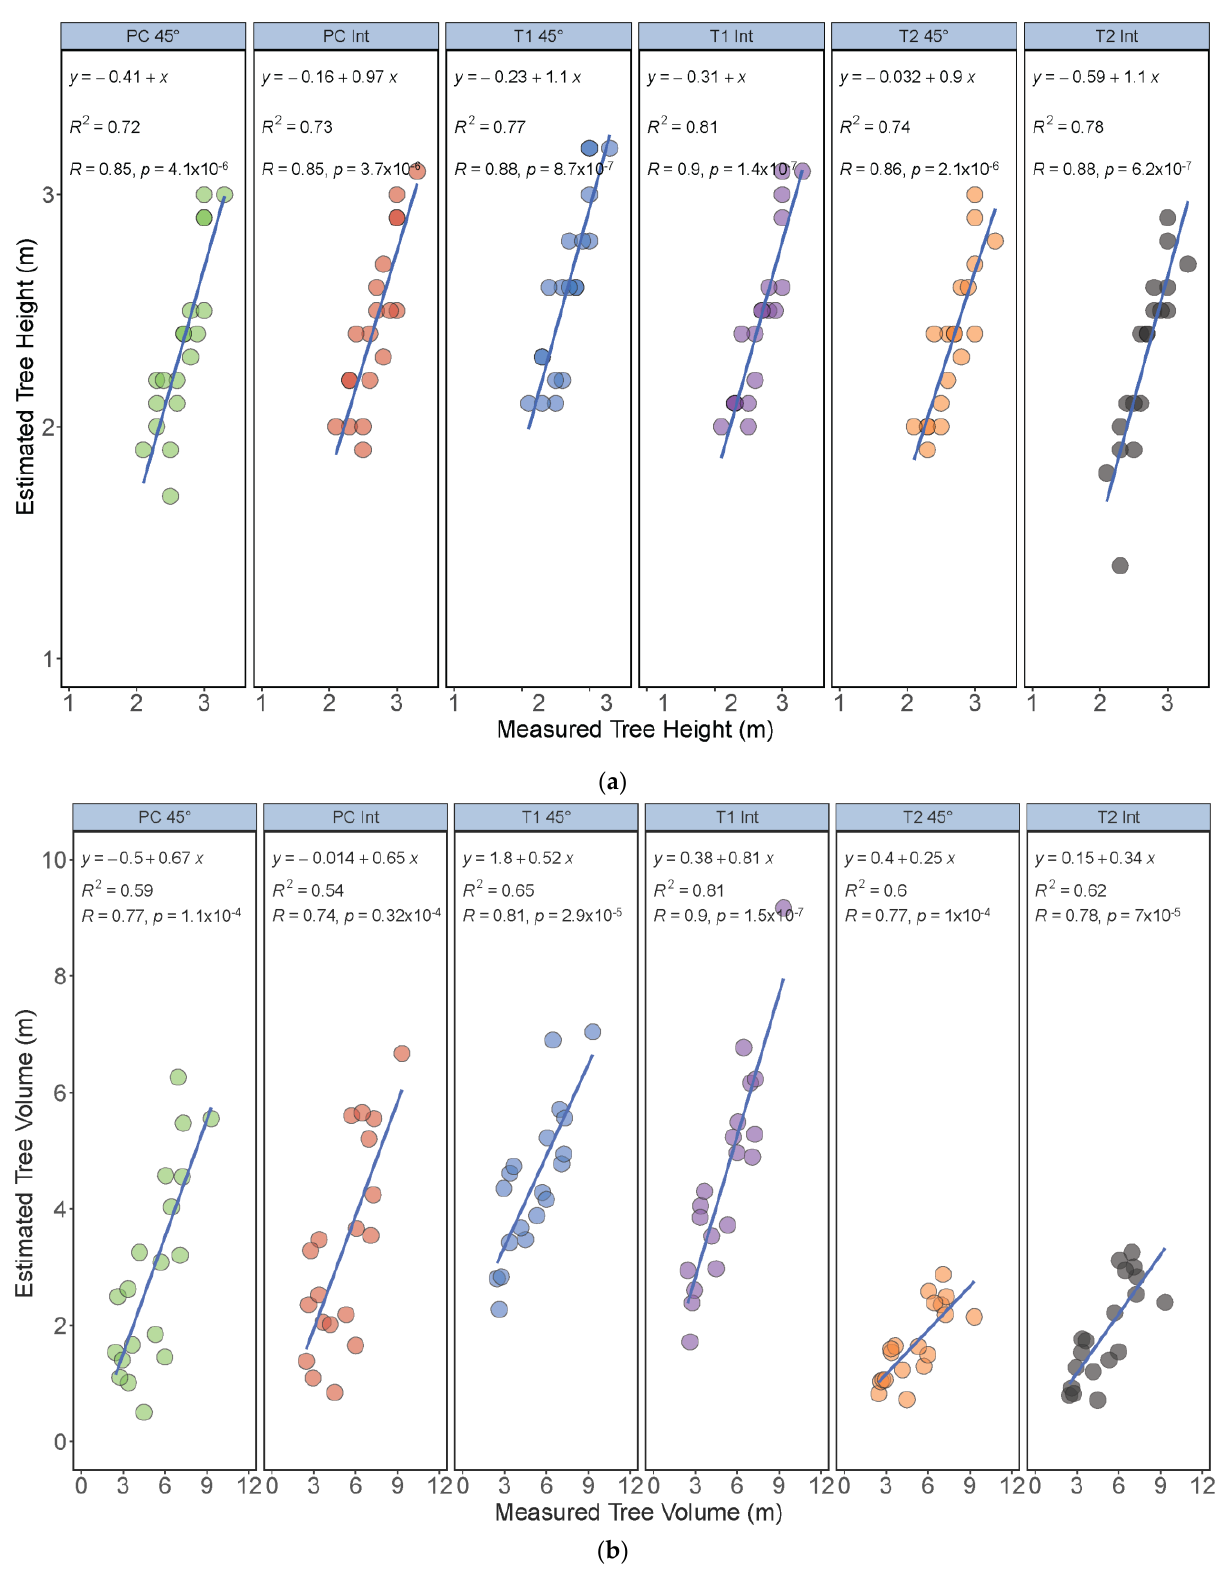
Figure 9. Relationship between the ground reference data and estimated tree height ( a ) and volume ( b ) acquired at 45° and the integrated nadir and oblique datasets using T1 (circular), T2 (polygon), and point cloud datasets, respectively.